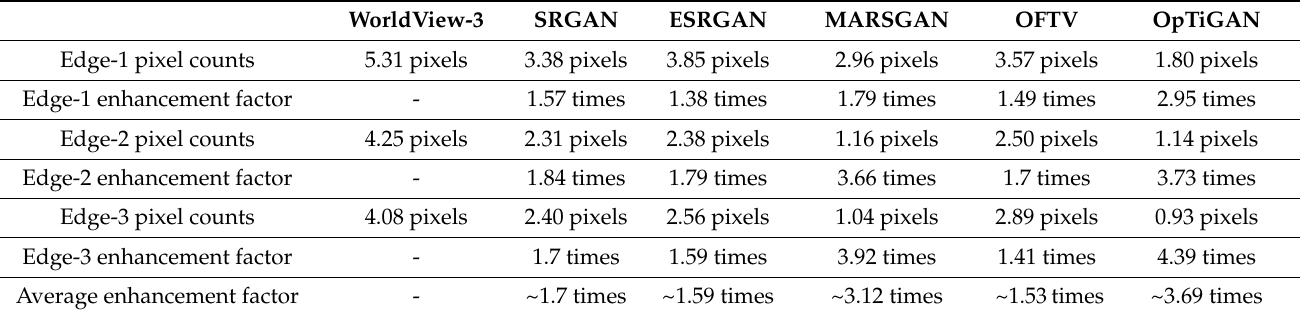
Table 3. Summary of slanted-edge measurements as shown in Figure 7, for total pixel counts for 20–80% rise of the edge profile and the suggested effective resolution enhancement factor comparing to the input WorldView-3 image (upscaled by a factor of 4 for comparison).